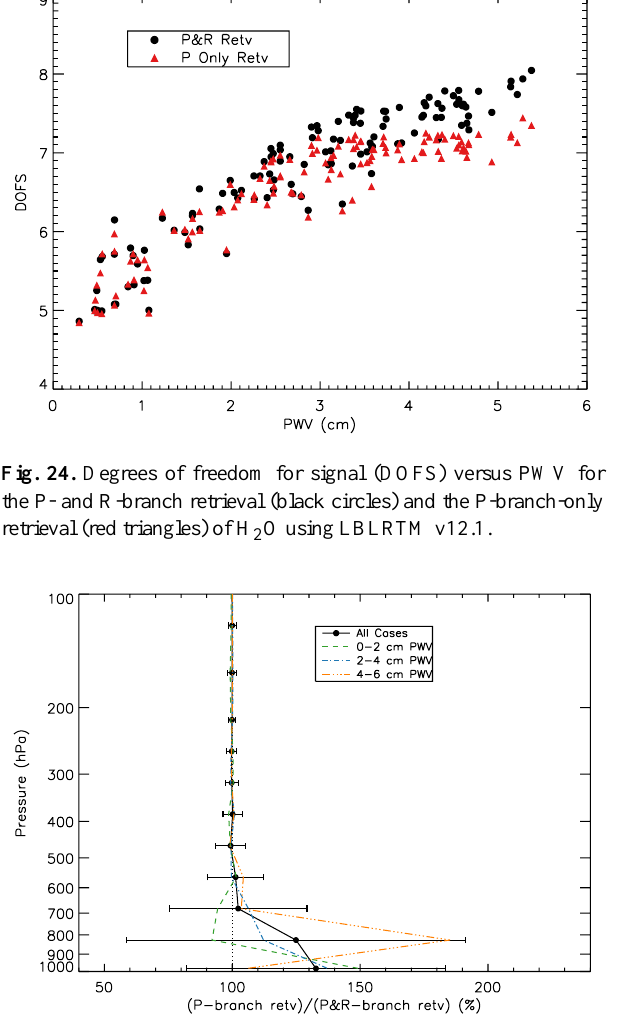
Fig. 25. Mean (black circles) and standard deviation (error bars) of the ratio of the 120 H 2 O profiles retrieved with LBLRTM v12.1 using the P branch of the ν 2 band of H 2 O to the profiles retrieved using both the P- and R-branches. Dashed lines show the mean dif- ferences for the spectra with 0–2cm (green), 2–4cm (blue), and 4–6cm (orange) PWV.